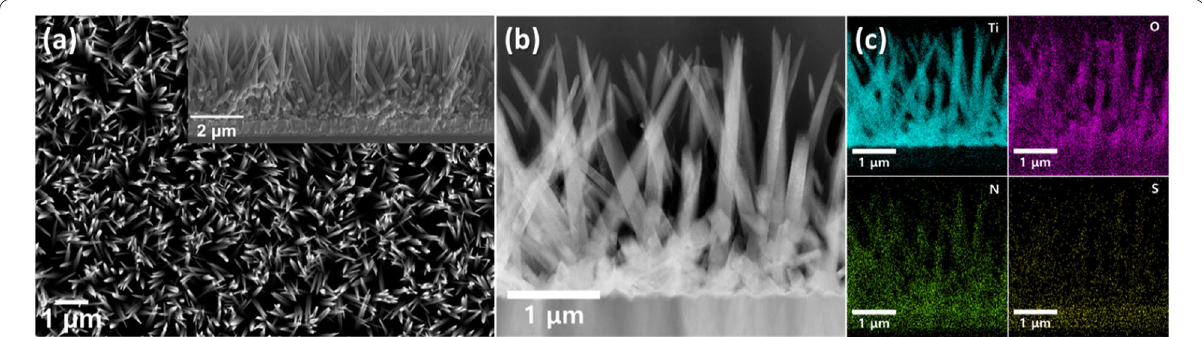
Fig. 6 Nanostructure of S, N-doped TiO 2 nanorod arrays annealed under H 2 atmosphere at 350 °C, selected as the optimum H 2 treatment condition. a Planar view obtained by FESEM. Cross-sectional view is also displayed by inset image. b Planar view investigated by STEM and c corresponding EDS elemental mapping results